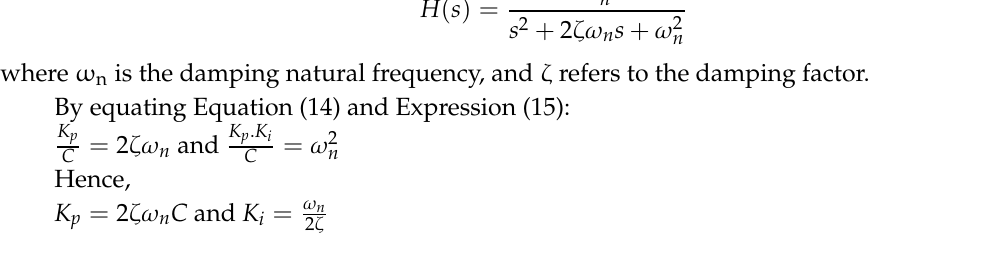
Figure 6. DC voltage control closed-loop.